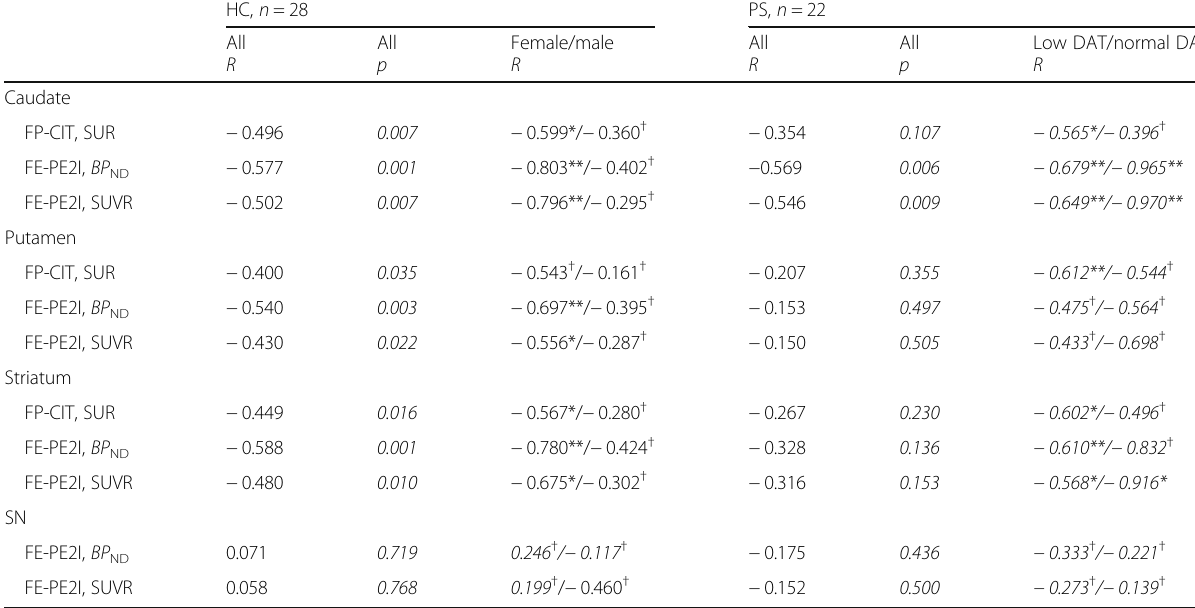
Table 2 Age correlation with DAT activity, measured with FP-CIT SPECT and FE-PE2I PET